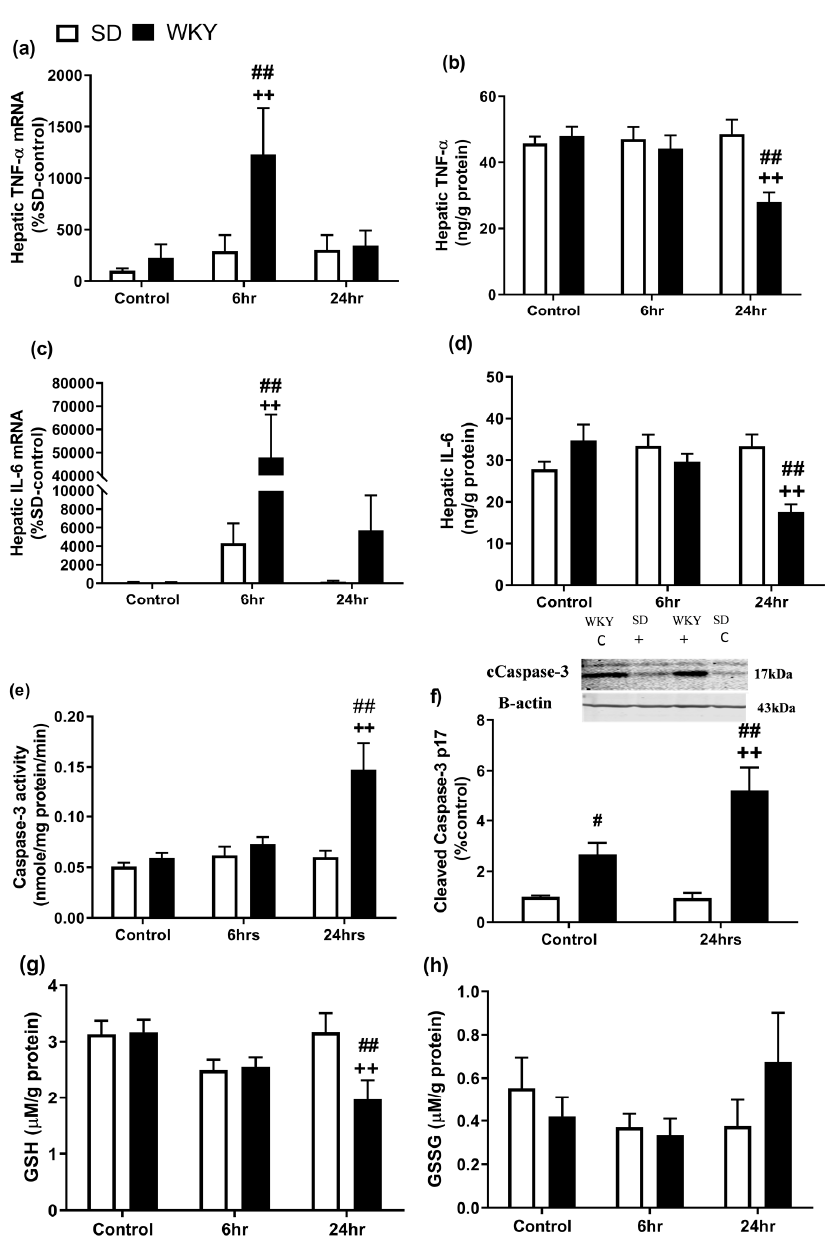
Figure 3. Effect of LPS/GalN on hepatic ( a , b ) TNF- α mRNA and protein levels, ( c , d ) IL-6 mRNA and protein levels, ( e , f ) caspase-3 activity and expression, ( g ) GSH and ( h ) GSSG activity 6 and 24 h post administration ( n = 6–8). ++ p < 0.01 vs. WKY control; # p < 0.05, ## p < 0.01 vs. SD counterparts. Data expressed as mean ± SEM ( n = 4–8).